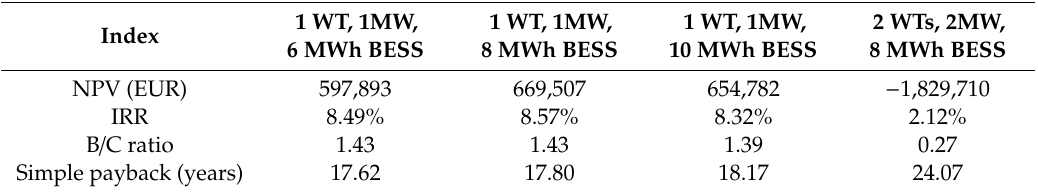
Figure 5. Total net present value (NPV) of HPPs containing one WT and different battery energy storage system (BESS) capacity. Table 1. Financial indices for a number of considered scenarios. IRR, internal rate of return; B / C ratio, benefit-to-cost ratio.